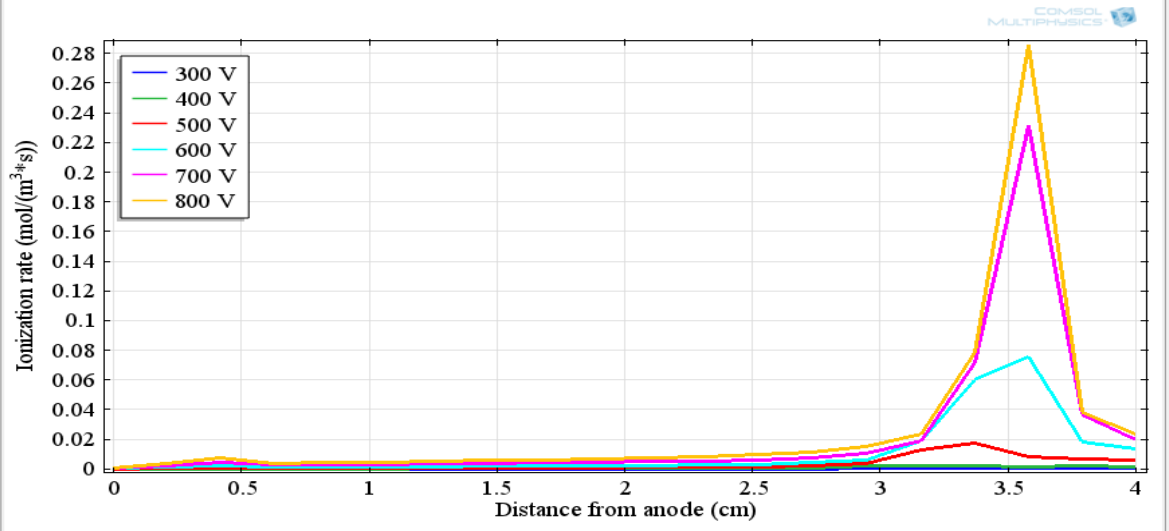
Fig. 11: Ionization rate as a function distance from anode at different discharge voltages.